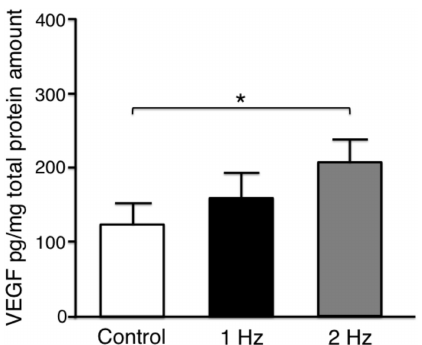
Figure 6. Comparison of the vascular endothelial growth factor (VEGF) concentrations secreted from tenocytes at di ff erent tensile frequencies in relation to the total protein. 5% stretch was applied for 3 h. The values were expressed as mean + SEM (pg / mg) ( n = 7). * p < 0.05 indicates significance. SEM, standard error of the